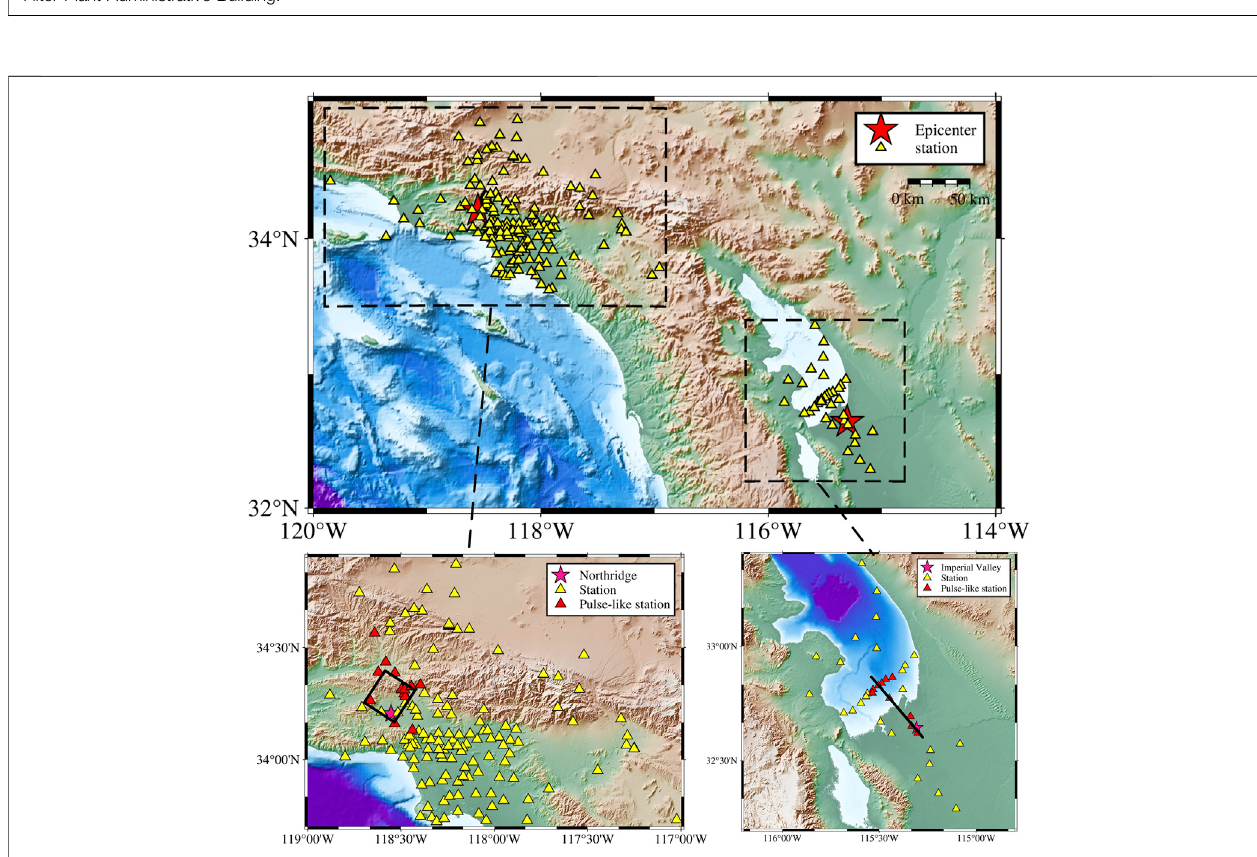
FIGURE1| Anexampleofpulse-likegroundmotionidenti fi edbyPPM.ThereddottedlinerepresentstheextractedpulsefromtheNorthridgestationintheJensen Filter Plant Administrative Building.